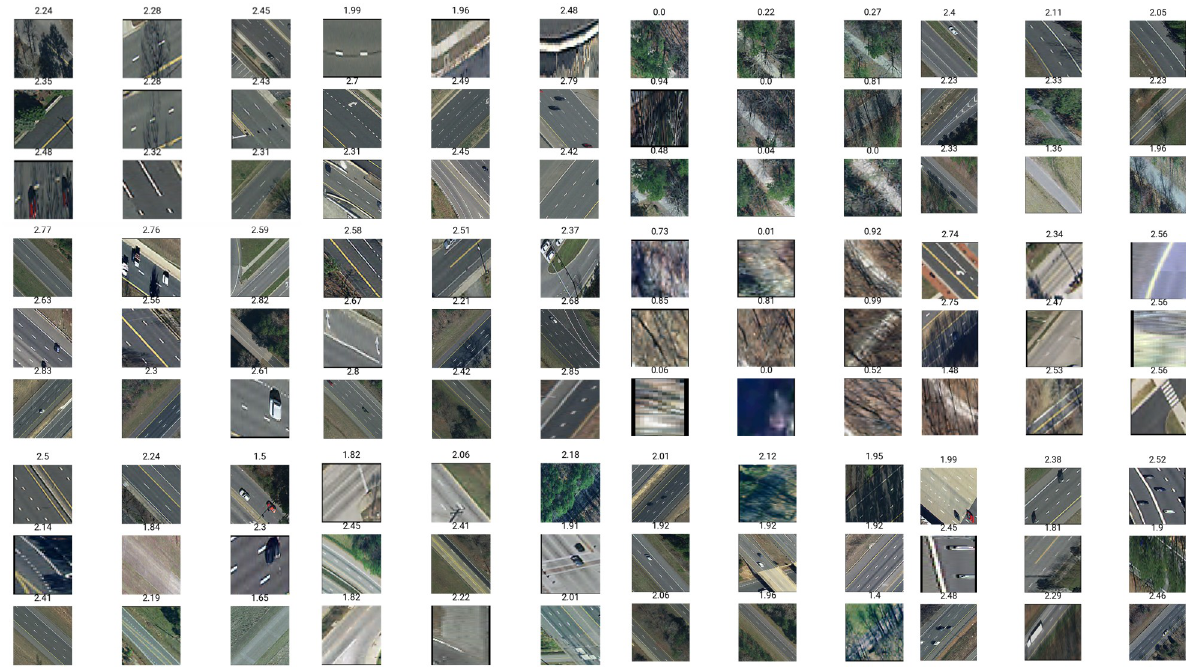
Fig 2. Random Virginia images. Random sample of cropped road segment images resized to 200x200 with corresponding labels. Values in the range [0–1] correspond to low quality roads, [1–2] corresponds to mid-quality, and [2–3] for high quality.